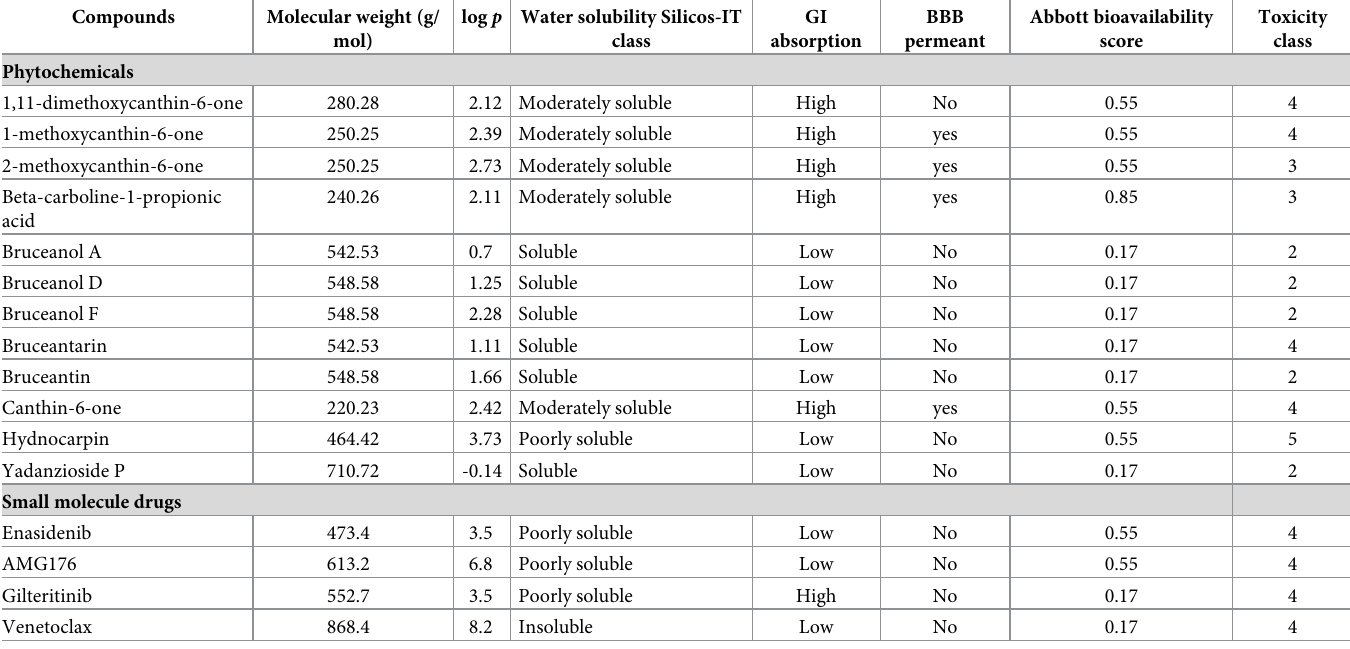
Table 3. Calculated physicochemical properties and toxicity class of selected B . antidysentrica phytochemicals and small molecule drugs. Compounds